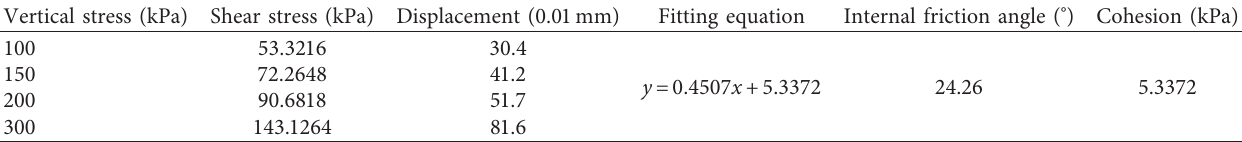
Table 4: Results of the direct shear test.